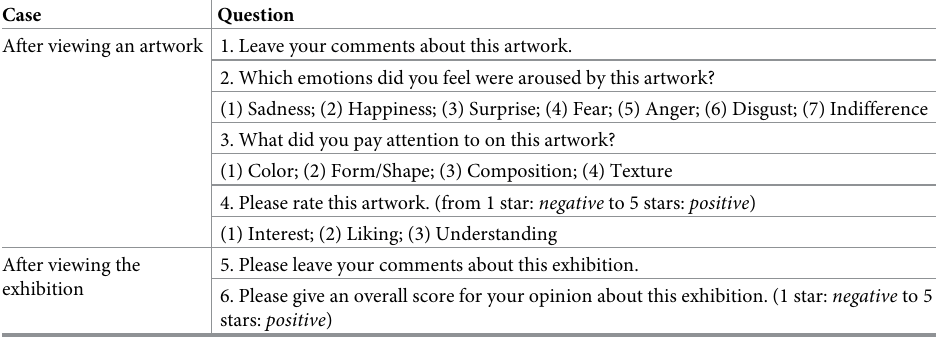
Table 1. VSCI elements to which participants responded in the observation